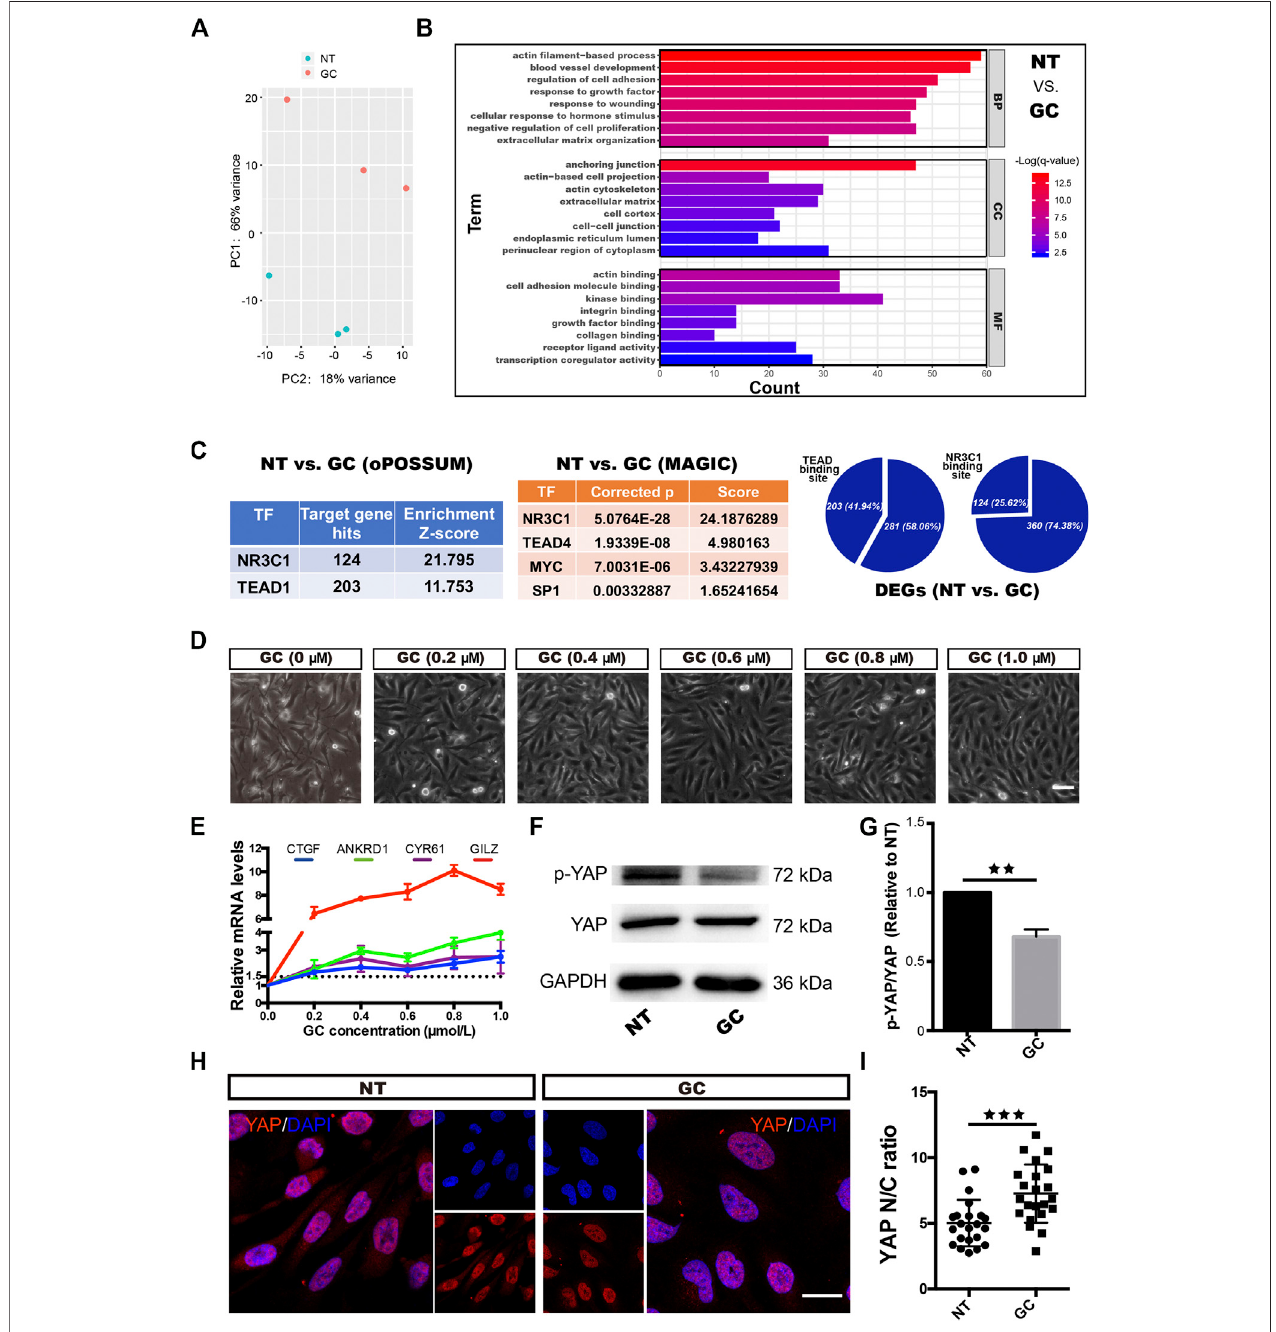
FIGURE 2 | GCs induce YAP activation in HRCECs. (A) : PCA was performed on samples from the NT group and the GC group. HRCECs were cultured in RPMI 1640medium(Gibco)containing10%FBS(Gibco)alone(NTgroup)orincombinationwith0.8 μ Mhydrocortisone(GCgroup)for72 h. (B) :Topsigni fi cantlyenrichedGO terms for the DEGsbetweenthe NTgroup and the GCgroup for theBP, MF and CC categories. (C) : Selected factors found inthe TF binding site enrichment analysisof DEGs from the NT vs. GC comparisons. The analysis was performed through two methods. oPOSSUM-3 is a web-accessible software program. The MAGIC algorithmwasusedforanalysisinPython.Proportionofsigni fi cantlydifferentiallyregulatedgenesintheDEGswithpredictedTEADandNR3C1bindingsitesinpromoter regions. (D) : Bright fi eld microscopy image of HRCECs treated with different concentrations of hydrocortisone (GC) for 72 h. Scale bars, 100 μ m. (E) : Real-time qPCR analysis of HRCECs treated as in (D) . mRNA levels of GILZ (a target of GR) and ANKRD1/CYR61/CTGF (targets of YAP) are calculated. (F): WB analysis of YAP and p-YAPofHRCECstreatedwithorwithout0.8 μ Mhydrocortisonefor72 hp-YAPisphospho-S127. (G) :Thep-YAP/YAPin (F) isquanti fi edandnormalized toNTgroup. (H) :YAPwasstainedbyimmuno fl uorescenceinHRCECstreatedasin (F) .Scalebars,20 μ m. (I) :Quanti fi cationoftheratiooftheaverageimmuno fl uorescenceintensity of YAP between the nucleus and the cytoplasm of the cells in (H) . The error bars represent the mean ± SD, and the experiment was biologically repeated three times. ** p < 0.01, *** p < 0.001. Student ’ s two-tailed paired t-test (G) or Student ’ s two-tailed unpaired t-test (I) . DEGs differentially expressed genes, GO Gene Ontology, BP biological process, CC cellular component, MF molecular function, TF transcription factor.